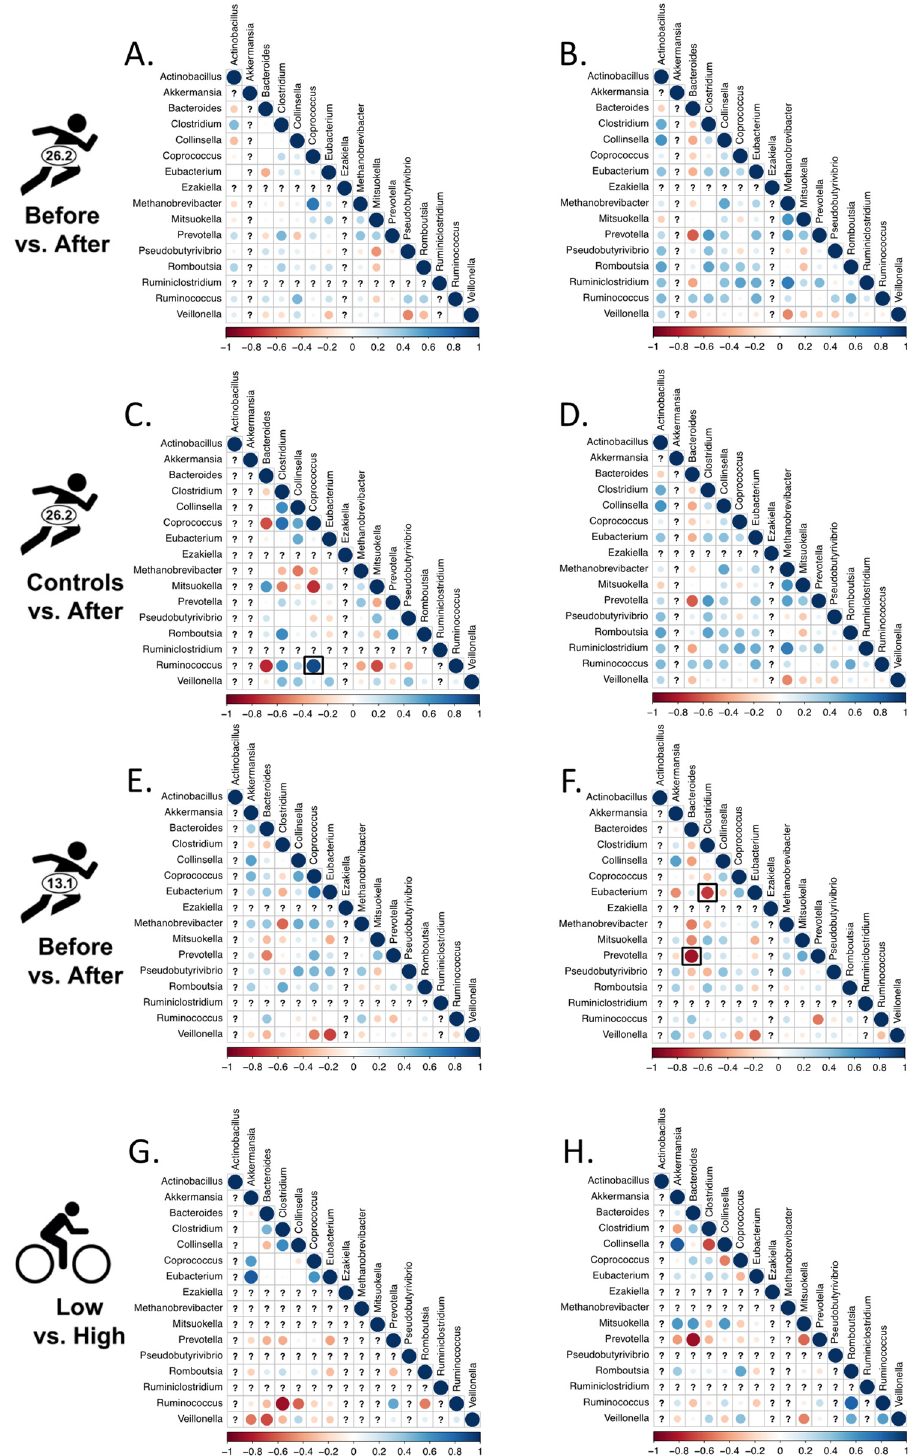
Figure 4. Pairwise Spearman’s rank correlations for target genera. The direction of the correlation (r) is indicated with the color of the circle (red = negative correlation; blue = positive correlation). Stronger correlations are indicated with greater color intensity and larger diameter of the circle. Significant correlations are boxed in black ( p < 0.05 after Benjamini–Hochberg correction). Question marks represent taxa that were not detected in each dataset. Athletes before ( A ) and after ( B ) the Boston Marathon; controls ( C ) versus athletes after ( D ) the Boston Marathon; before ( E ) and after ( F ) the Chongqing Half Marathon; high ( G ) and low ( H ) training groups of USA competitive cyclists.